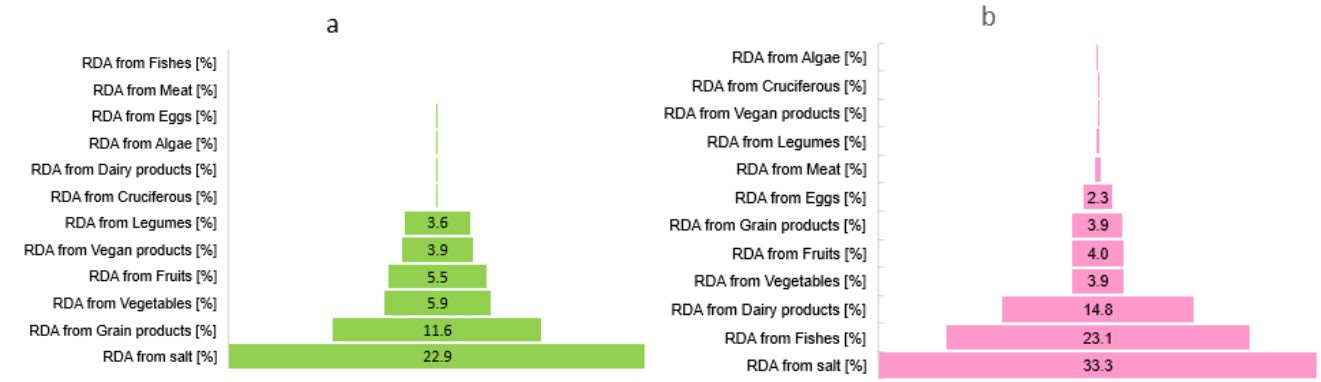
Figure 3. Ranked covering of the RDA for iodine from products among women and men with the vegan diet ( a ) and the omnivore diet ( b ) aged 18 – 80 from Poland.